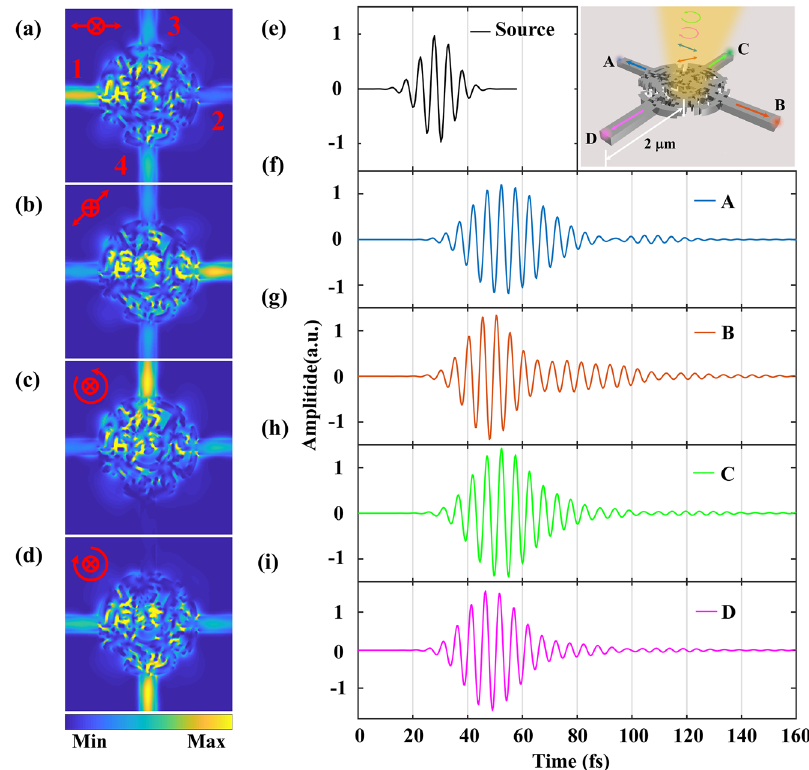
Figure 2: Simulation results of the